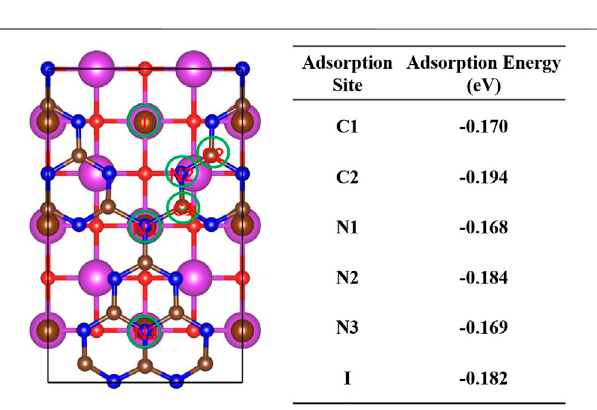
FIGURE7| Theadsorption energy ofCO 2 atdifferentadsorptionsitesin BiOBr/g-C 3 N 4 .